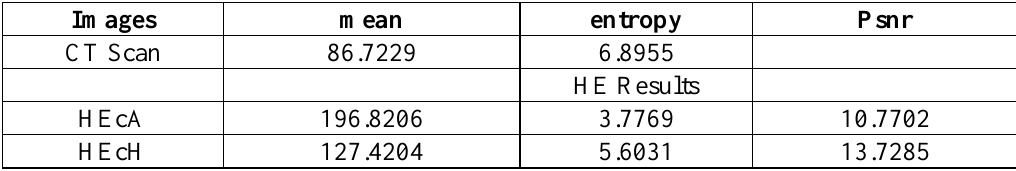
Fig.4: Canny edges detection results and histogram for the images: (a) CT Scan image, (b) AHEcA, (c) AHEcH, (d) AHEcV and (e) AHEcD. Table 1: Results measures of CT-Scan